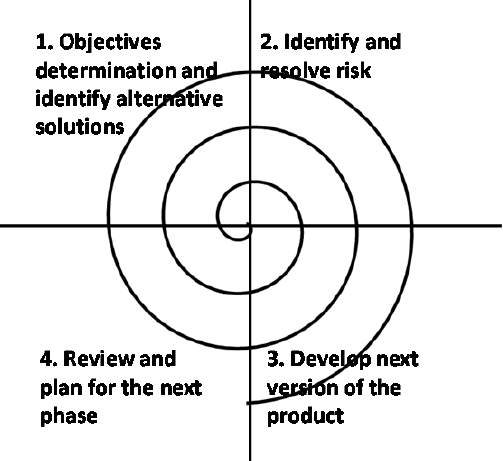
Fig. 1. Spiral Software Model, adapted from